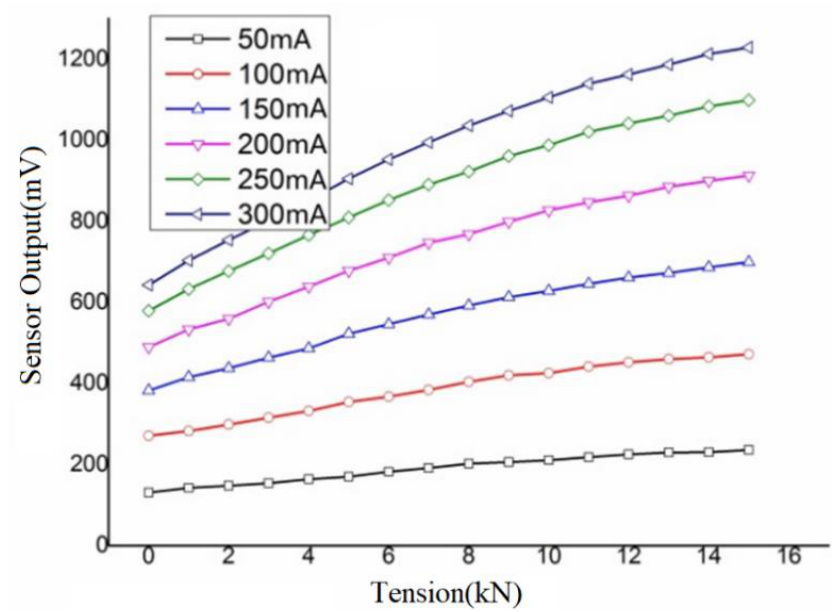
Figure 9. Sense signal curve with stress variation of different current intensity.